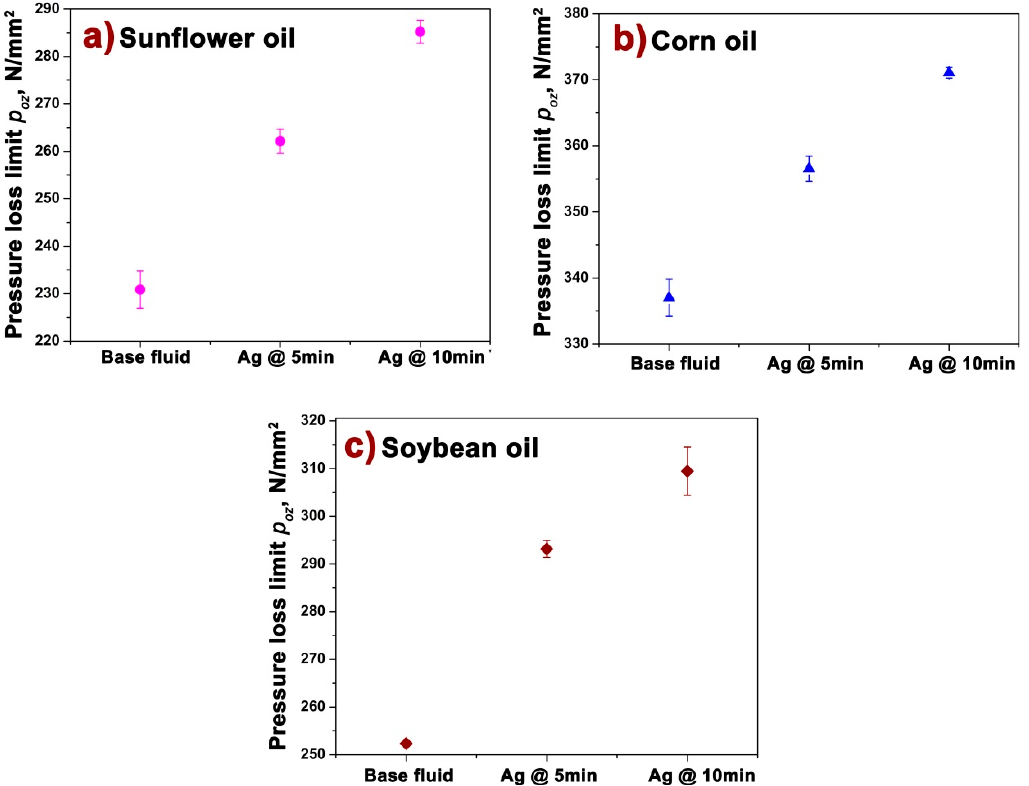
Figure 4. Tribological performance of Ag-vegetable nanofluids at 5 and 10 min laser ablation times. ( a ) Sunflower oil, ( b ) Corn oil and ( c ) soybean oil.